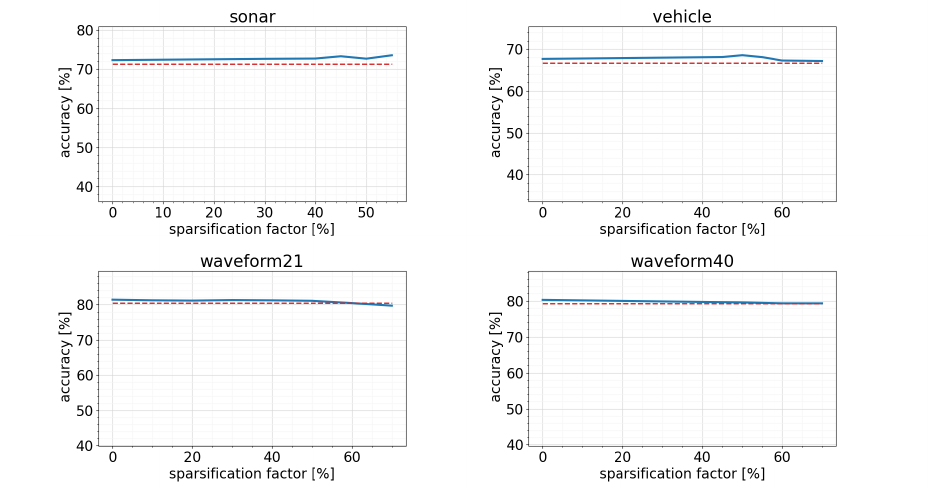
Figure 16. Results of pruning DT structure on heart, hepatitis, ionosphere and page-blocks datasets.